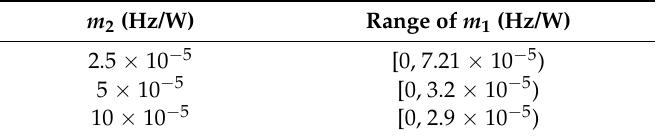
Table 1. The influence of active droop coefficients between DG1 and